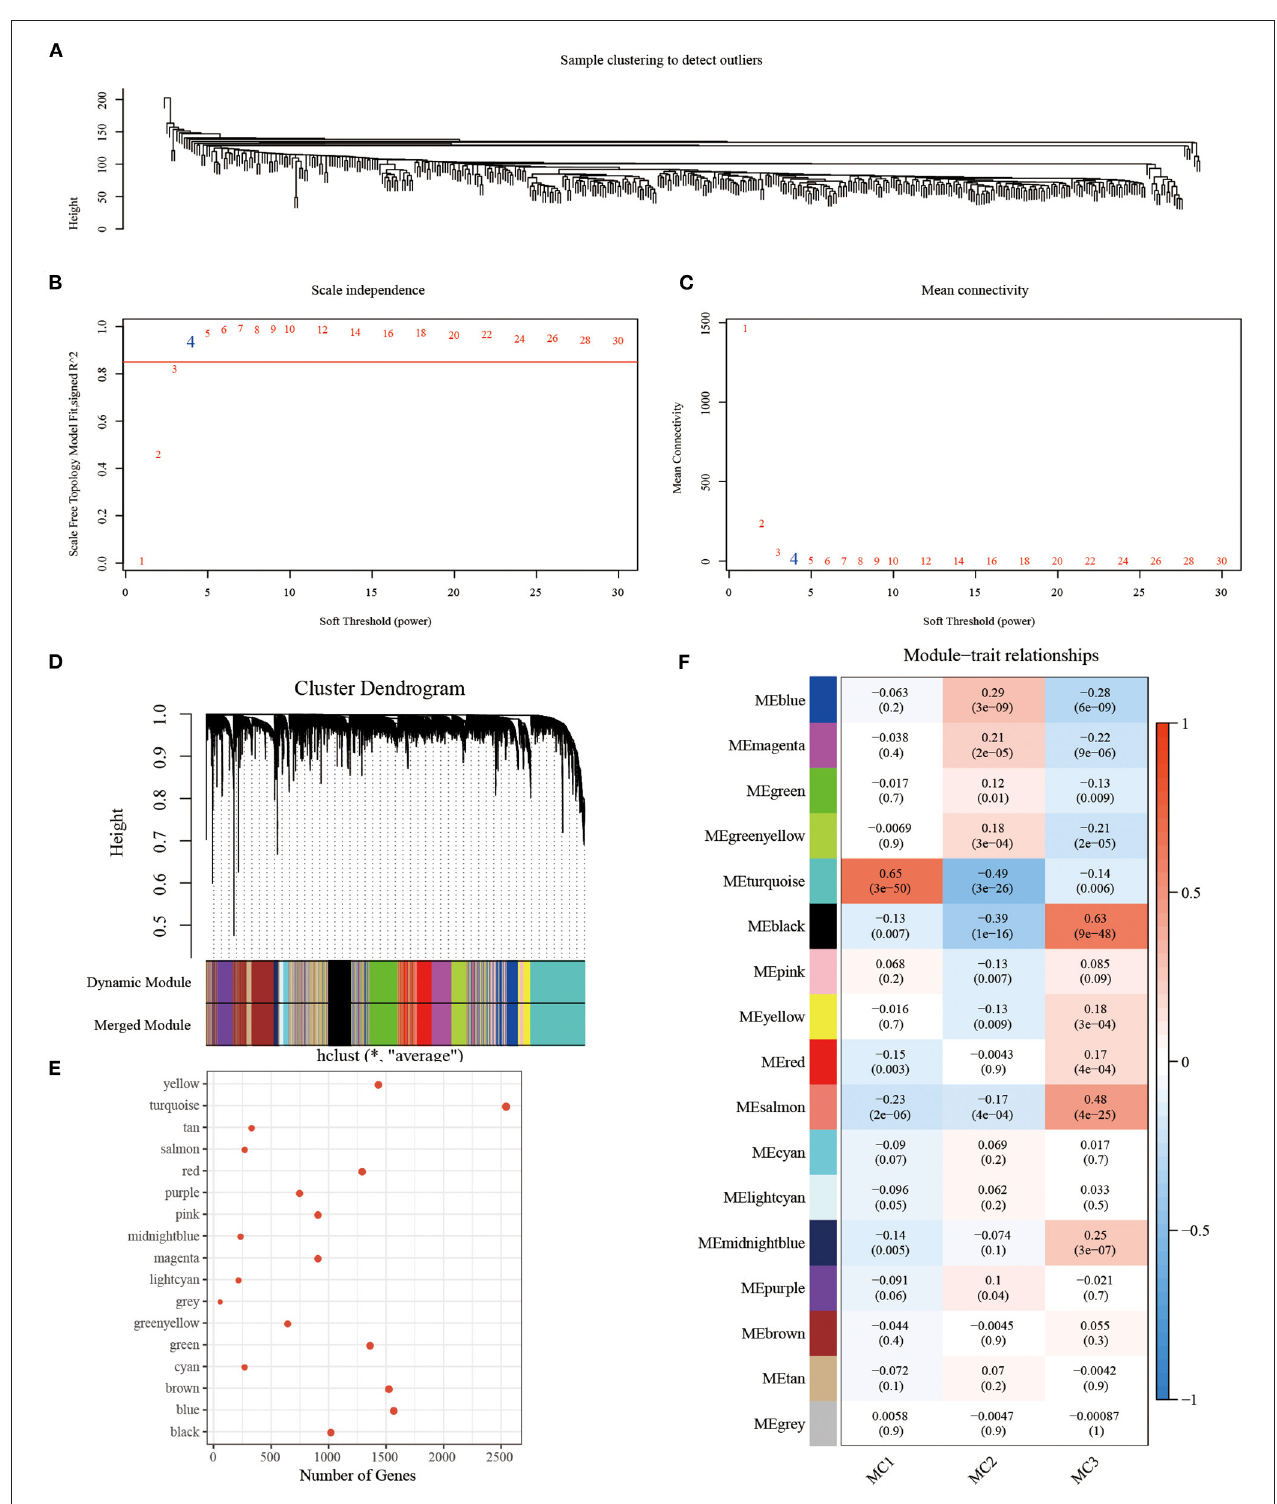
FIGURE 9 | (A) Clustering tree of each sample; (B) Analysis of the scale-free fit index for various soft-thresholding powers ( β ). (C) Analysis of the mean connectivity for various soft-thresholding powers. (D) Dendrogram of all differentially expressed genes/lncRNAs clustered based on a dissimilarity measure (1-TOM); (E) statistics of the number of genes in each module; (F) correlation between each module and